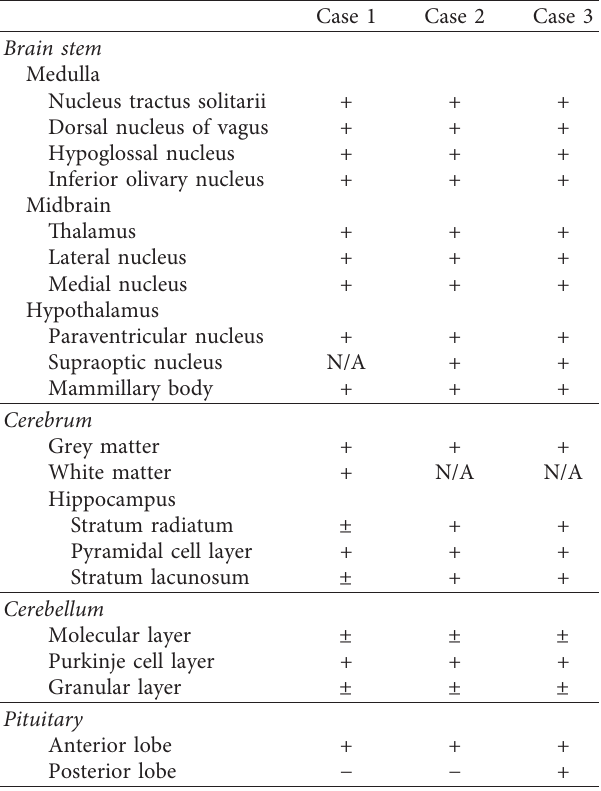
Table 3: Distribution of (pro)renin receptor expression in the